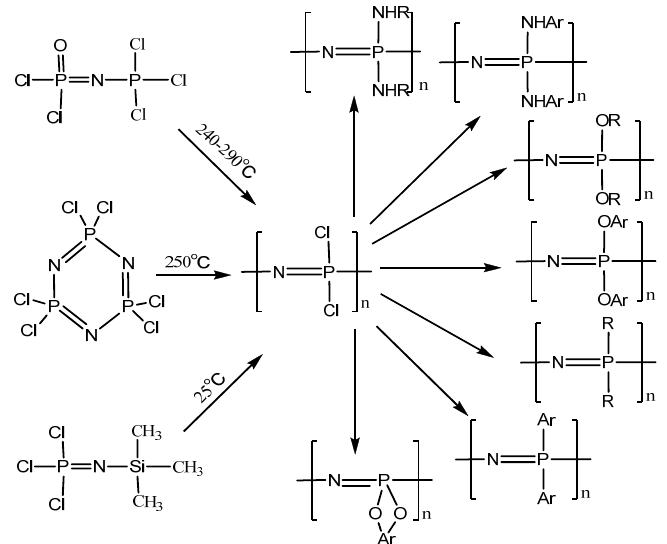
Figure 1. Synthetic schemes of the linear polyphosphazene derivatives. Taken with permission from [24,28].